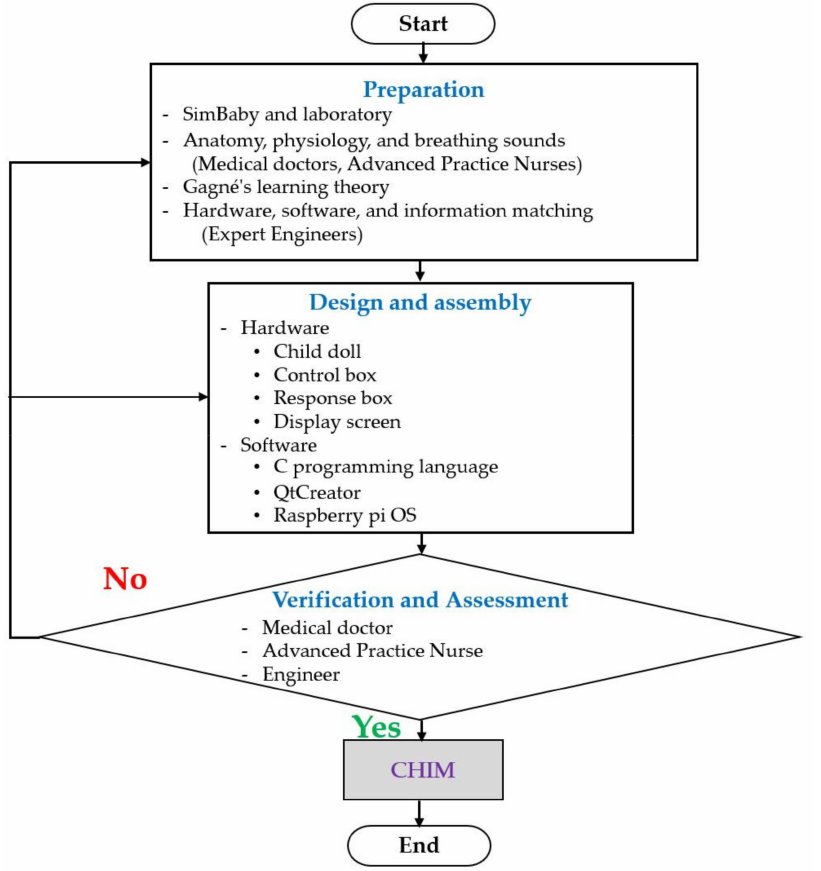
Figure 2. A flowchart of CHIM invention